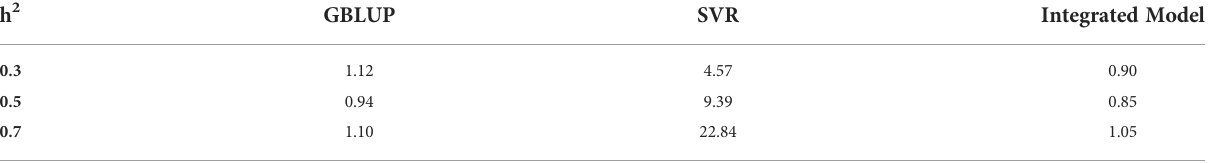
TABLE 3 Error variance for different GS models at different heritability using RCV. h